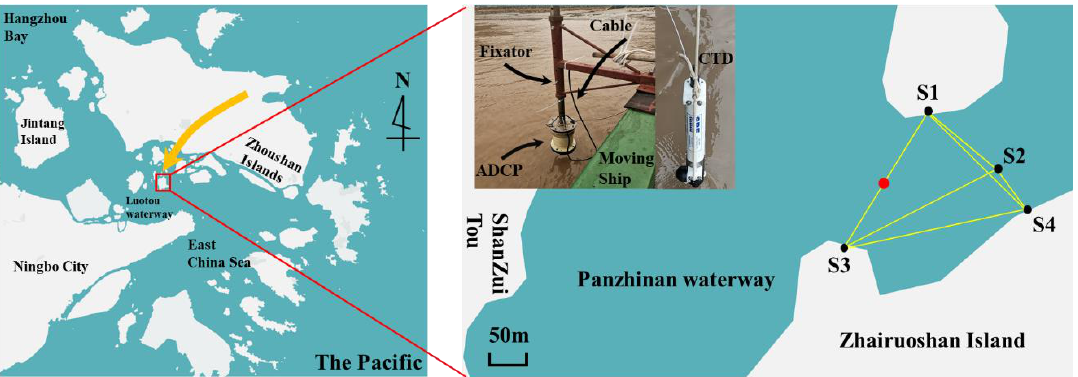
Figure 2. Map of the Panzhinan waterway near the Zhairuoshan Island with adjacent regions (left panel) and the CAT station array at a magnified scale (right panel).